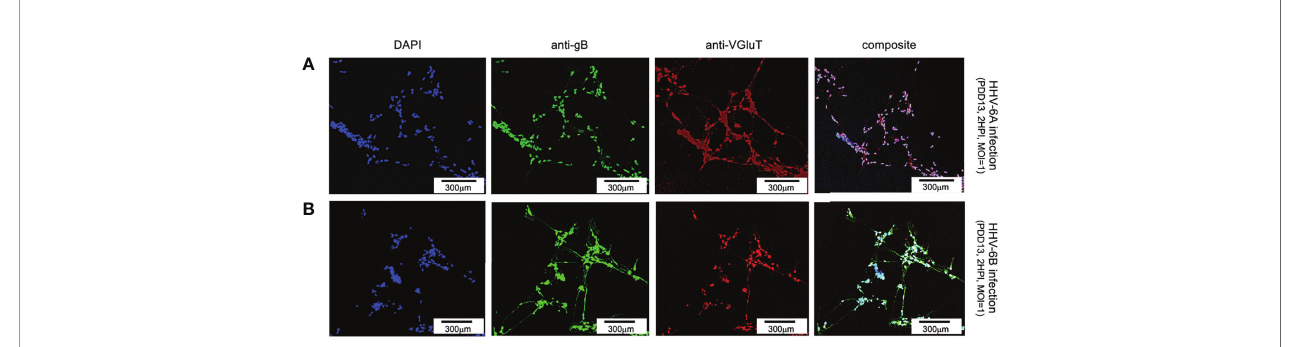
FIGURE 6 | Fluorescence microscopy images of dHNSC treated with immuno fl uorescent antibodies and a fl uoro-dye at PDD13: Glutamatergic neurons. VGluT1- positive dHNSC at PDD13 (2 HPI, MOI=1) shown (left to right) by DAPI staining, anti-gB, and anti-VGluT immuno fl uorescence (with composites) indicate that gB (green) colocalizes with VGluT1 (red) in DAPI stained (blue) cells for both HHV-6A (row A ) and HHV-6B (row B ) infected cultures, suggesting susceptibility of glutamatergic neurons to both viruses. (Results were consistent across 6 replicate trials). [Scale bar = 300 micron].